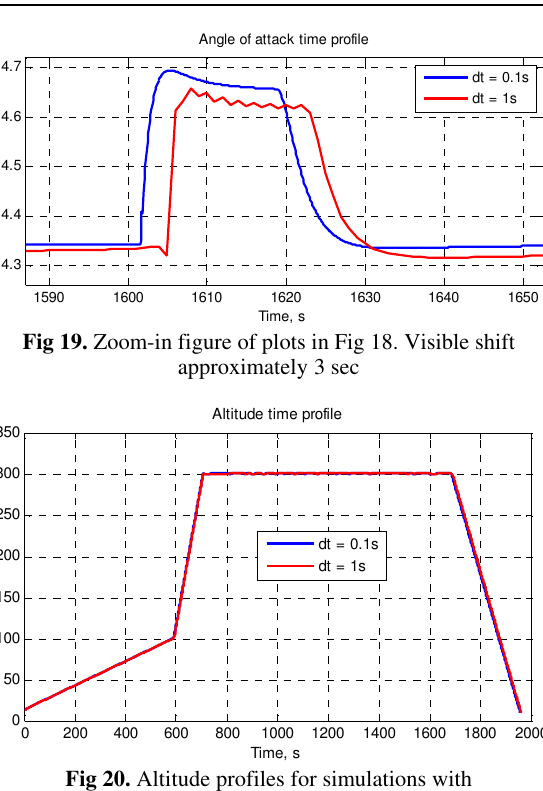
Fig 20. Altitude profiles for simulations with different time steps